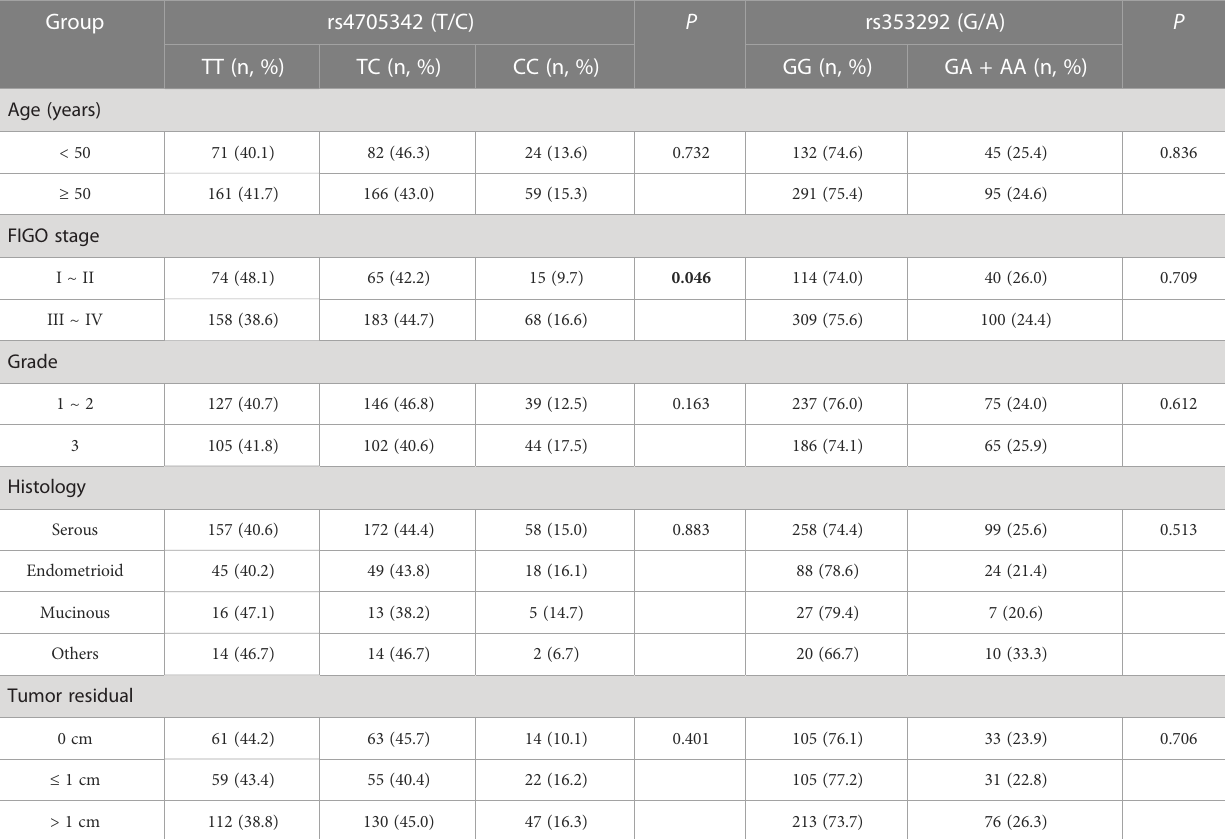
TABLE 2 Association of rs4705342 and rs353292 polymorphisms with the clinical characteristics of patients with epithelial ovarian cancer. Group